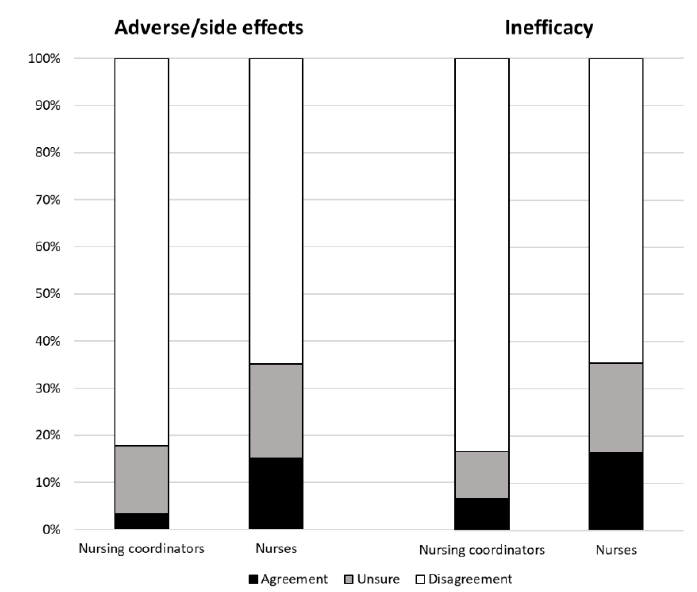
Figure 1. Frequency distribution (percentages) of the answers on the “adverse/side effects” and the “inefficacy” categories by qualification.